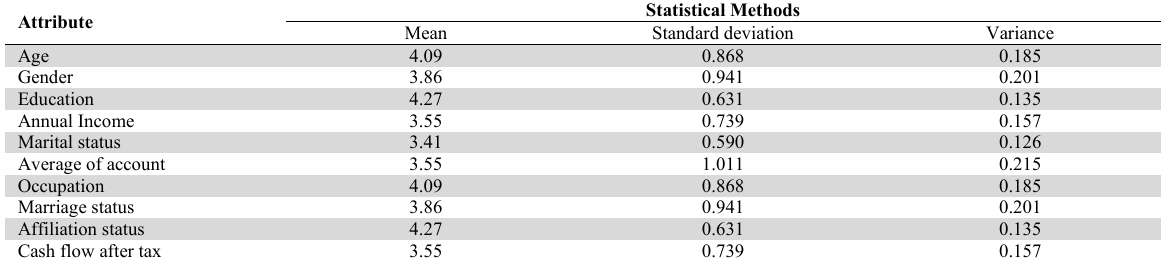
Statistical analysis of data set (bank 3)